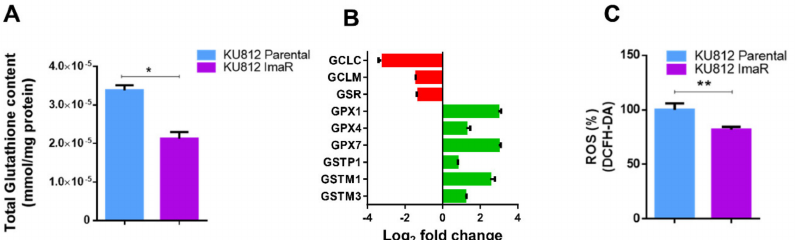
Figure 5. Di ff erences of glutathione metabolism between KU812 imatinib-resistant and KU812 Parental cells. ( A ) Total glutathione levels in KU812 Parental and imatinib-resistant (ImaR) cells in normoxia. Data are mean ± SD for n = 3 replicates. ( B ) The protein expression profiling of proteins associated with glutathione metabolism in KU812 ImaR and Parental cells under normoxia was obtained using SILAC-based proteomic experiments. Log2 fold change values were calculated and represented by green color = protein upregulation; and red = protein downregulation. ( C ) Intracellular reactive oxygen species (ROS) levels in KU812 Parental and ImaR cells in normoxia. Data are mean ± SD for n = 3 replicates. Statistically significant di ff erences in all the panels were determined by two-tailed independent sample Welch’s t -test when n < 3 and Student’s t -tests when n > 3: * p < 0.05, ** p < 0.01. Abbreviations: GCLC, glutamate-cysteine ligase catalytic subunit, GCLM, glutamate-cysteine